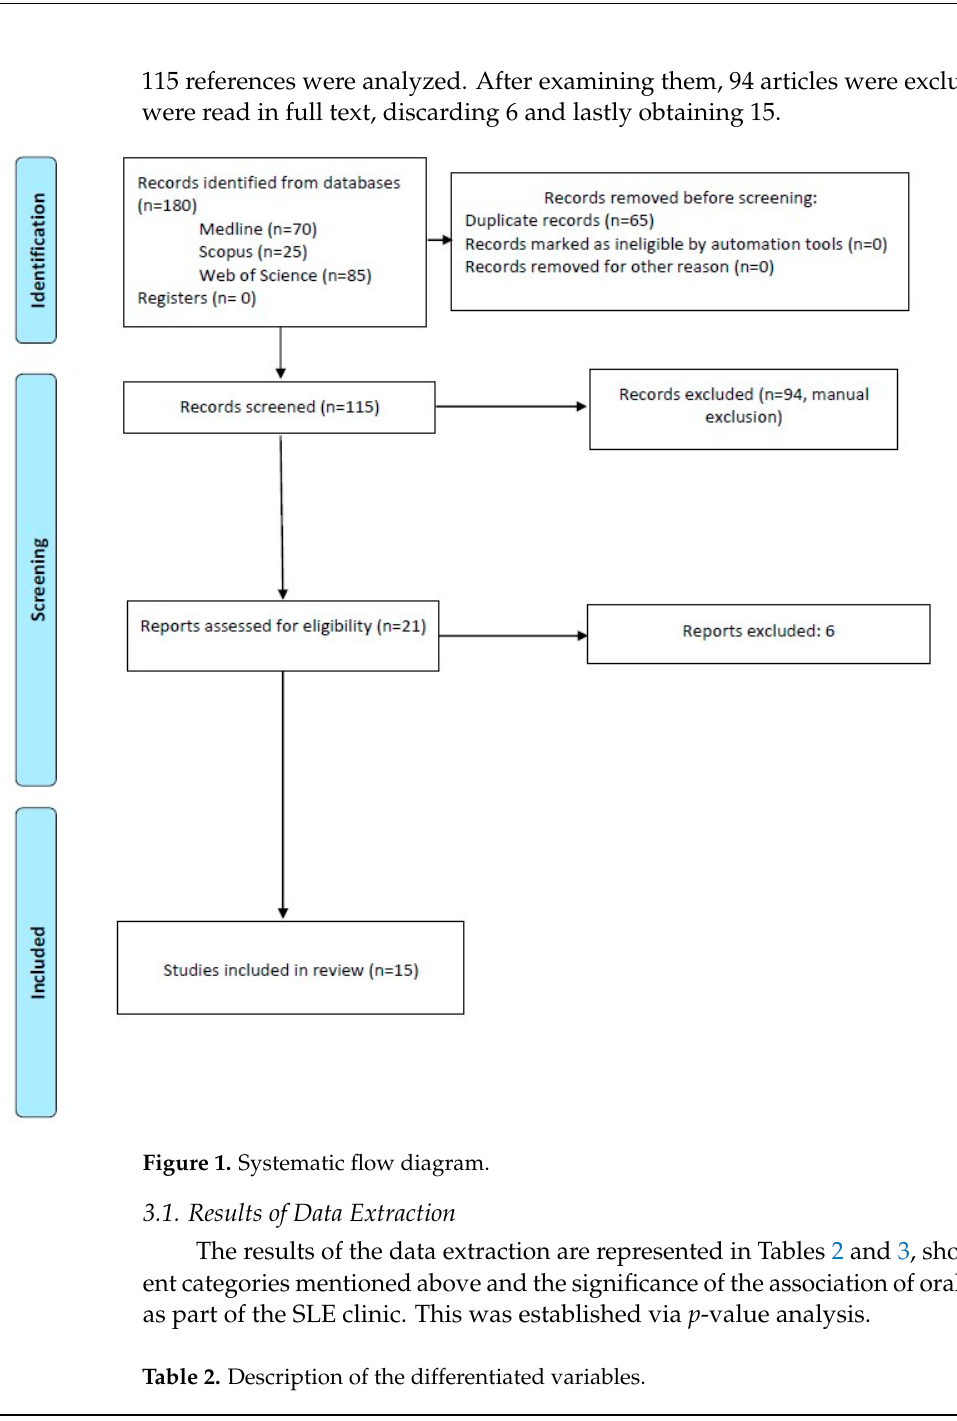
Table 2. Description of the differentiated variables.